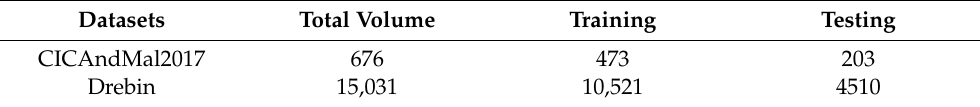
Table 3. Volume of datasets.